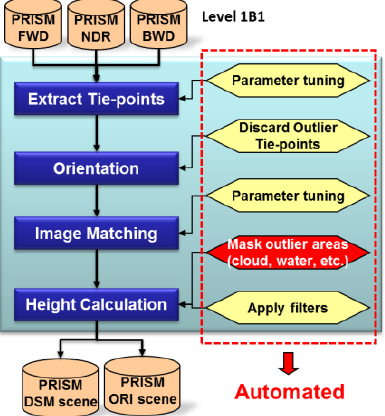
Figure 5. The processing flowchart of “DOGS-AP”